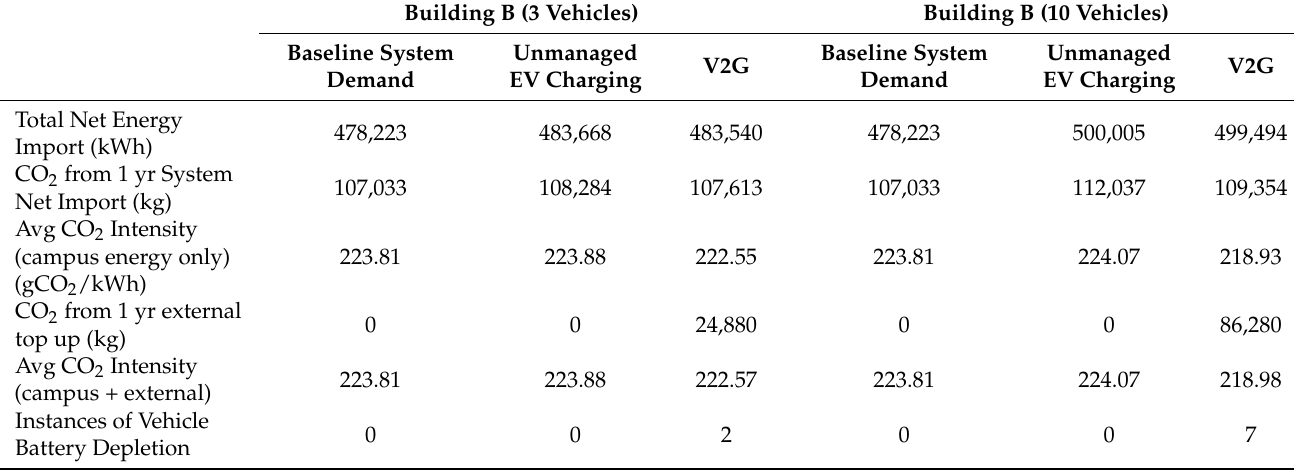
Table 12. Simulated CO 2 emissions of Building